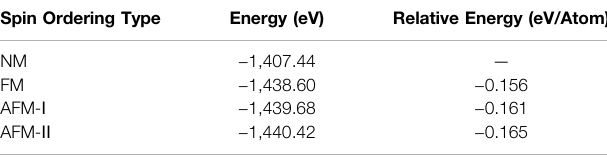
TABLE 3 | The total energies for each type of spin ordering and relative energies with respect to spin ordering NM. Spin Ordering Type